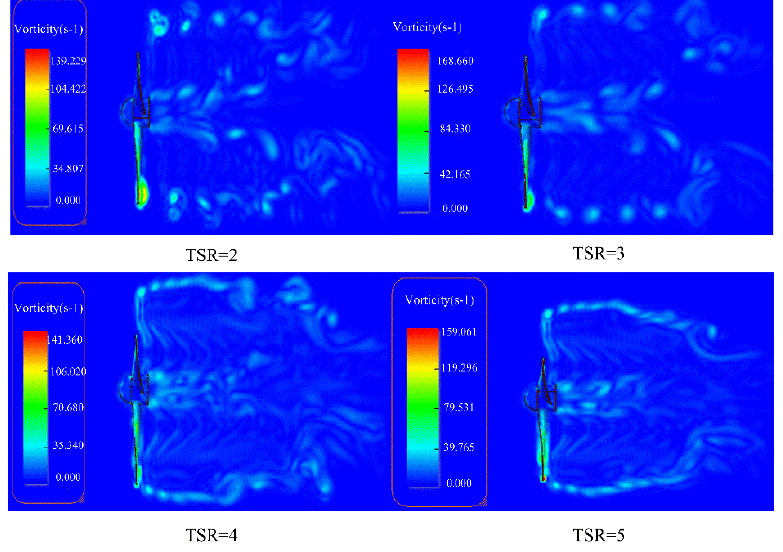
Figure 10. Vortex distribution of plane in different TSR.